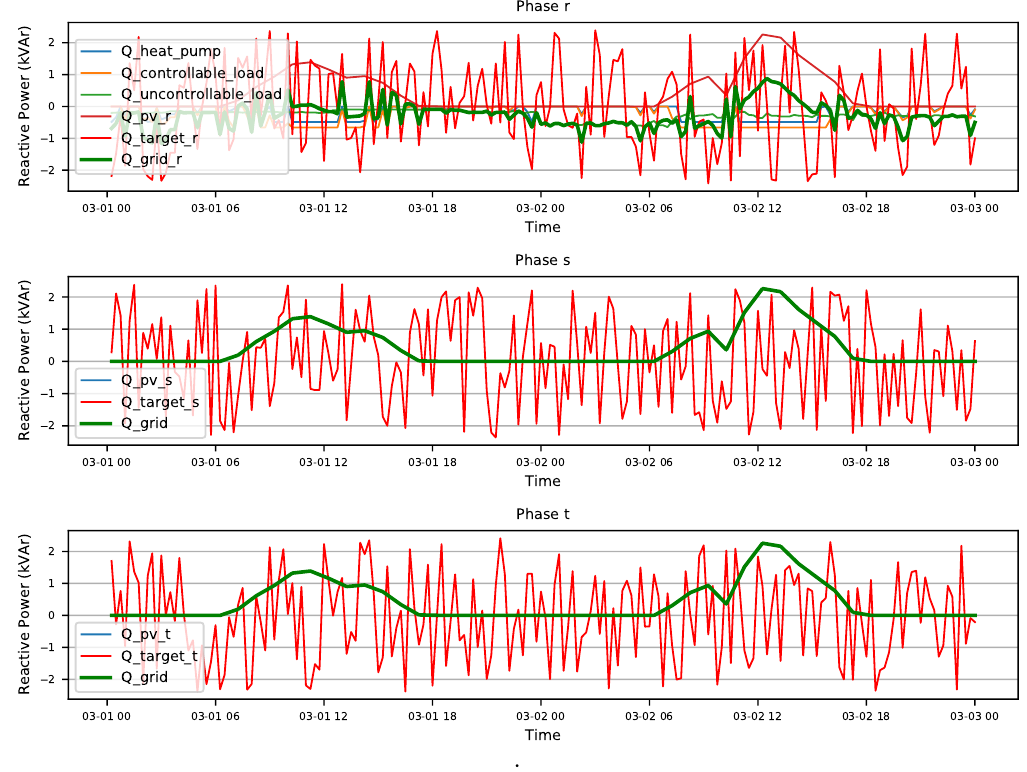
Figure 12. Per-phase reactive power controllable and disturbance variables for passive house and weight scenario ( S , U , G ) = ( 0,0,1